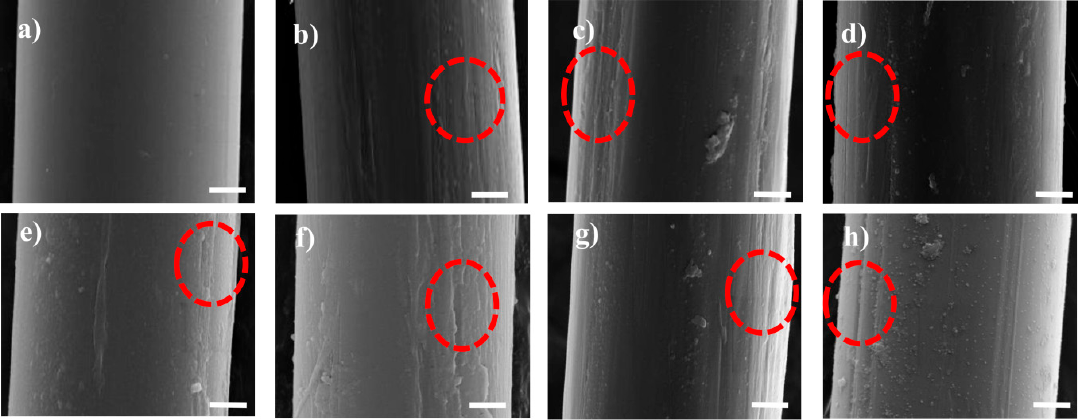
Figure 1. SEM images of aramid fiber surface morphology before and after scCO 2 treatment. ( a